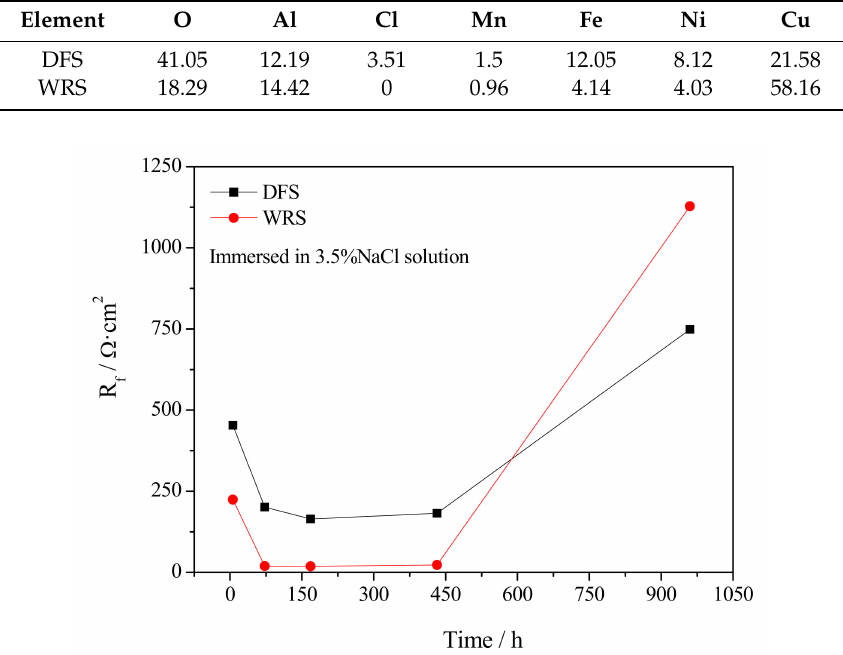
Figure 17. The R f evolution of DFS and WRS specimens with immersion time.